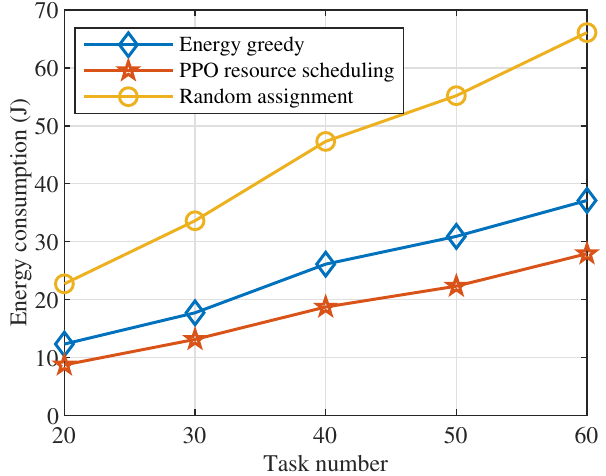
Figure 4. Energy consumption with different number of